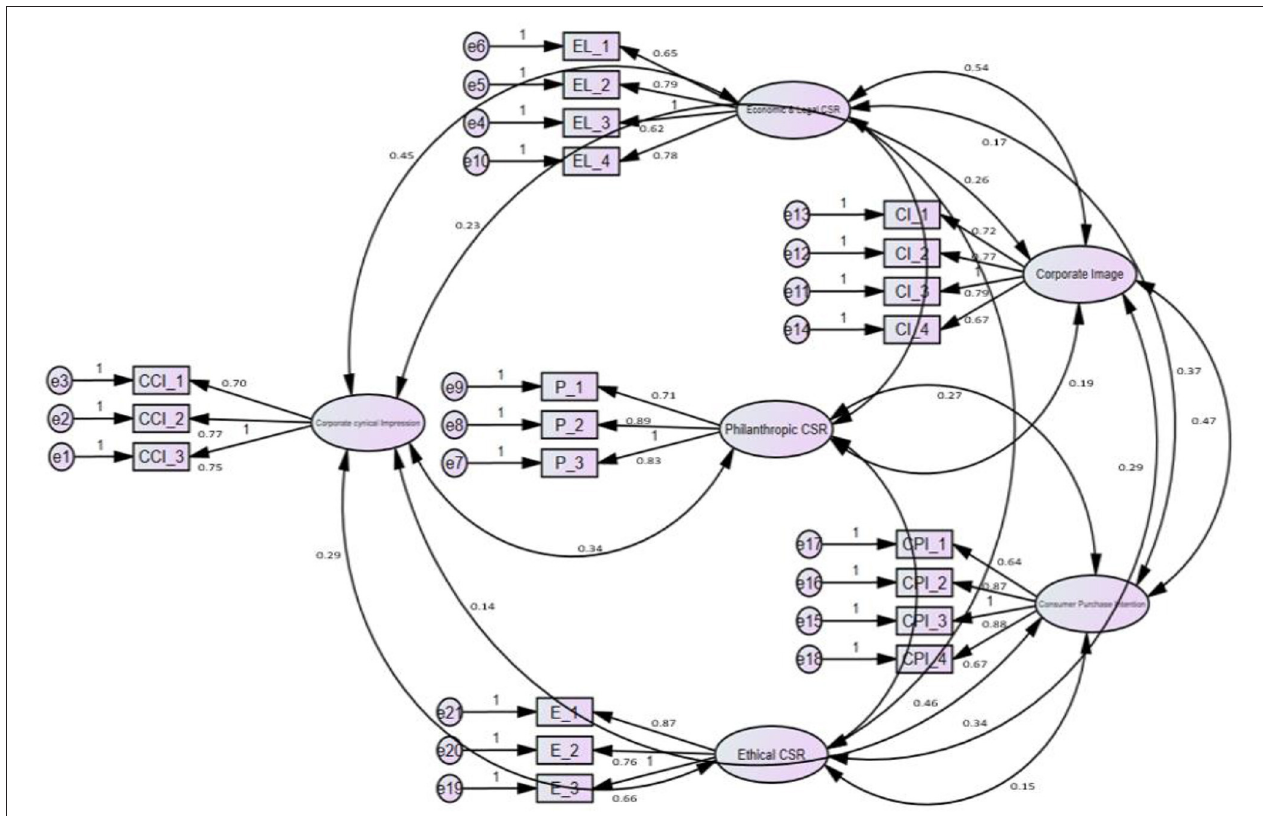
FIGURE 2 | Pooled CFA.